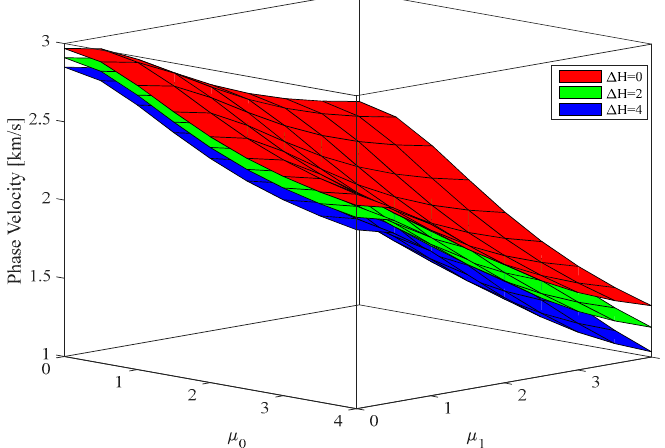
Figure 8. Influence of humidity on the phase velocity of P-FGM doubly-curved nanoshell vs. lower/higher order non-local parameters. ( k = 5 × 10 8 , R 2 = R 1 = 50 × h , n = 2, ξ = 0.1, λ = 2 ) .